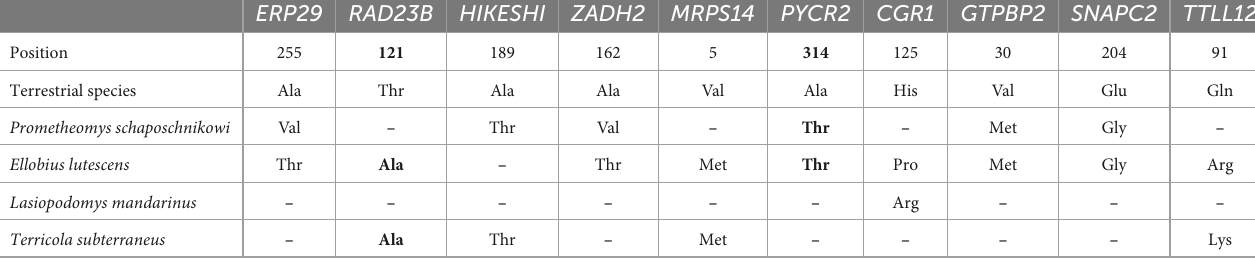
TABLE 1 Obtained genes with parallel amino acid substitutions shared in at least two subterranean species.